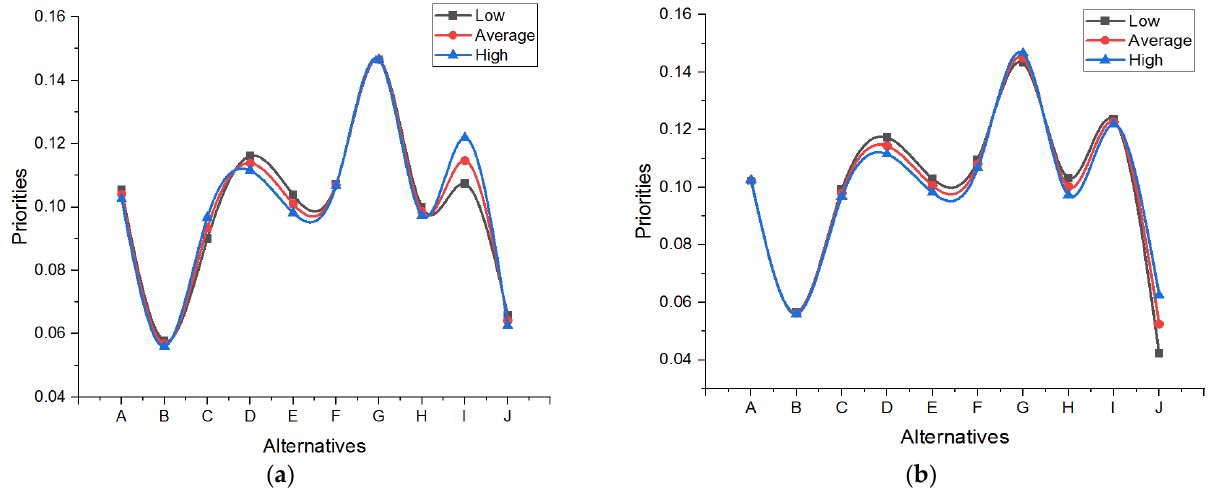
Figure 7. Distance and Speed Variance in Criteria 3. ( a ) Variation in Distance ( b ) Variation in Speed.